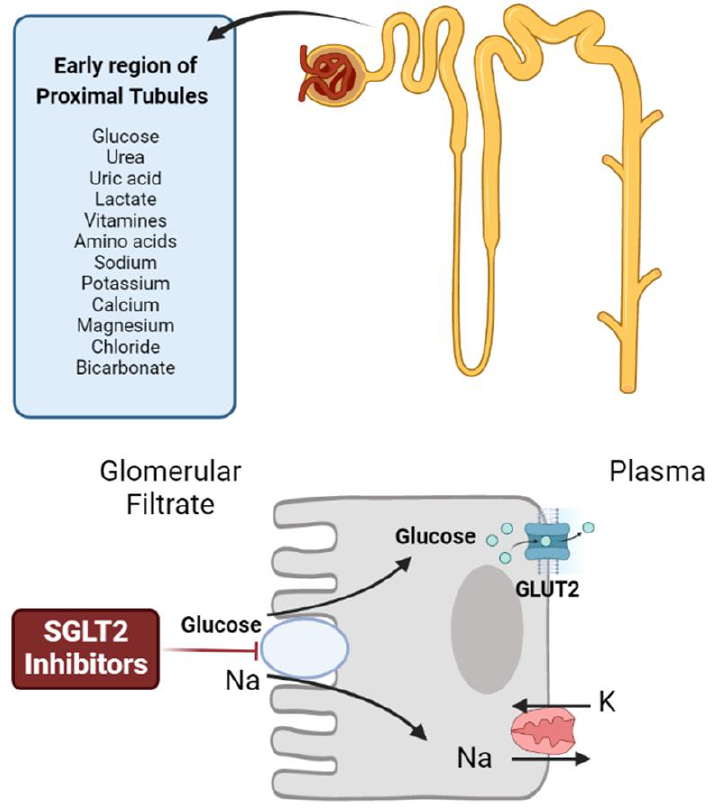
Figure 1. Mechanism of action of SGLT2 inhibitors.